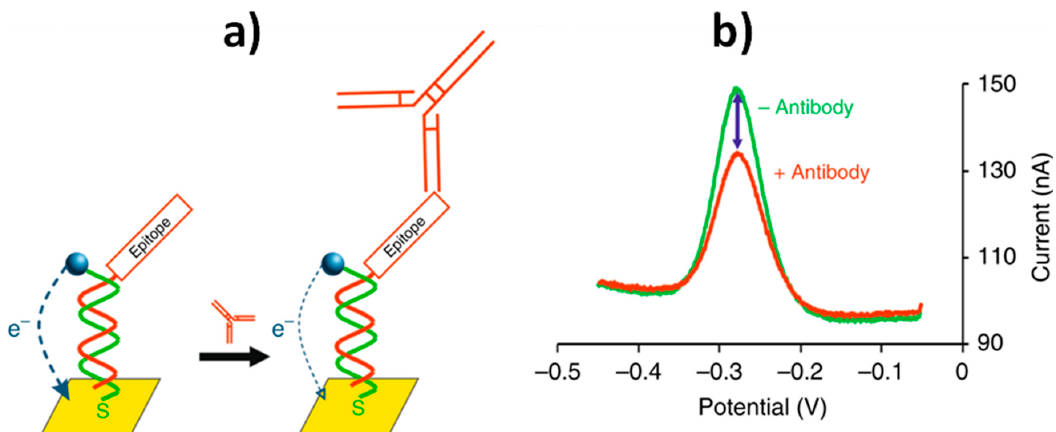
Figure 4. E-DNA sensor developed for the multiplexed determination of HIV-diagnostic antibodies using a nucleic acid “scaffold” anchored on one end to an electrode and presenting both a redox reporter and a specific epitope on the other. When the targeted antibody is not present, the DNA scaffold efficiently transfers electrons to the gold electrode, the electron transfer being reduced due to steric hindrance upon antibody binding ( a ); the square wave voltammetric signals obtained in the absence and in the presence of the targeted antibody ( b ). Reprinted and adapted from [25] with permission.